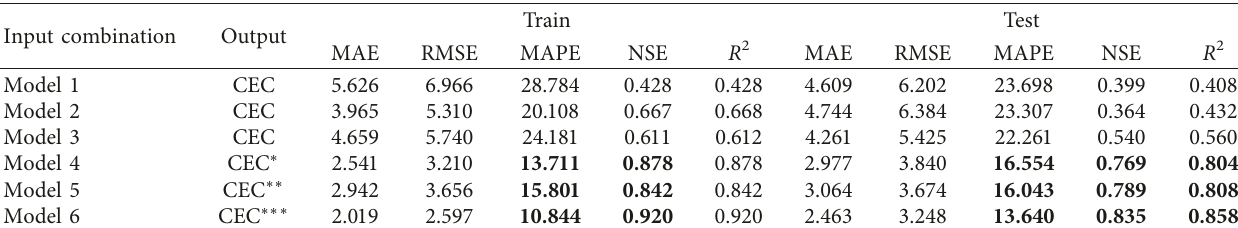
Table 4: The performance criteria of the ELM model for six input combinations.